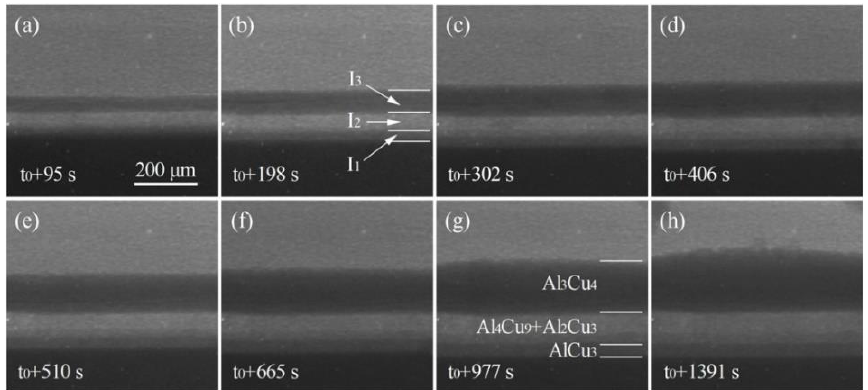
Figure 7. Sequence of in situ radiographs ( a – h ) showing the growth of IMCs layers ( t 0 is assigned to the onset of colling).